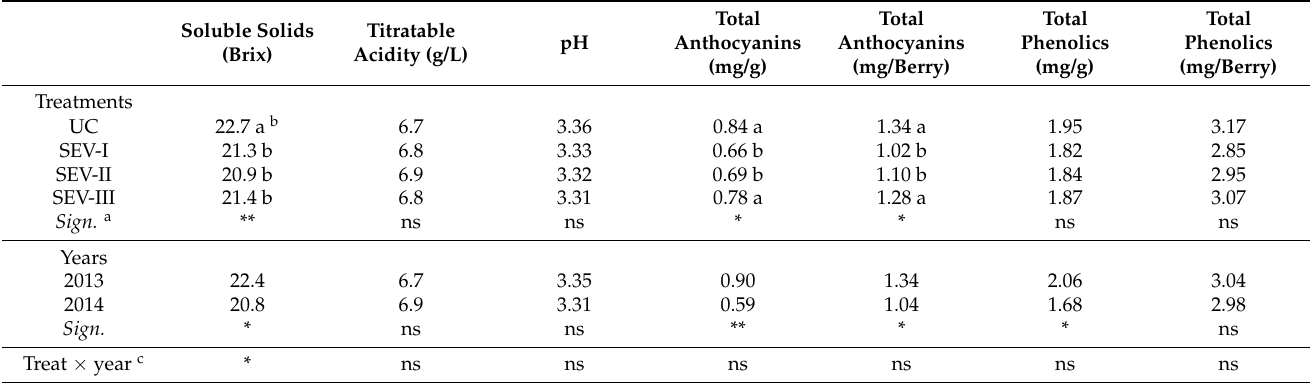
Table 3. Berry composition of Merlot grapevines subjected to severe shoot trimming at different phenological stages (mean values for 2013 and 2014). UC, untreated control; SEV-I, severe shoot trimming when berries were 4 mm in diameter; SEV-II, severe shoot trimming at early veraison; SEV-III, severe shoot trimming at late veraison.